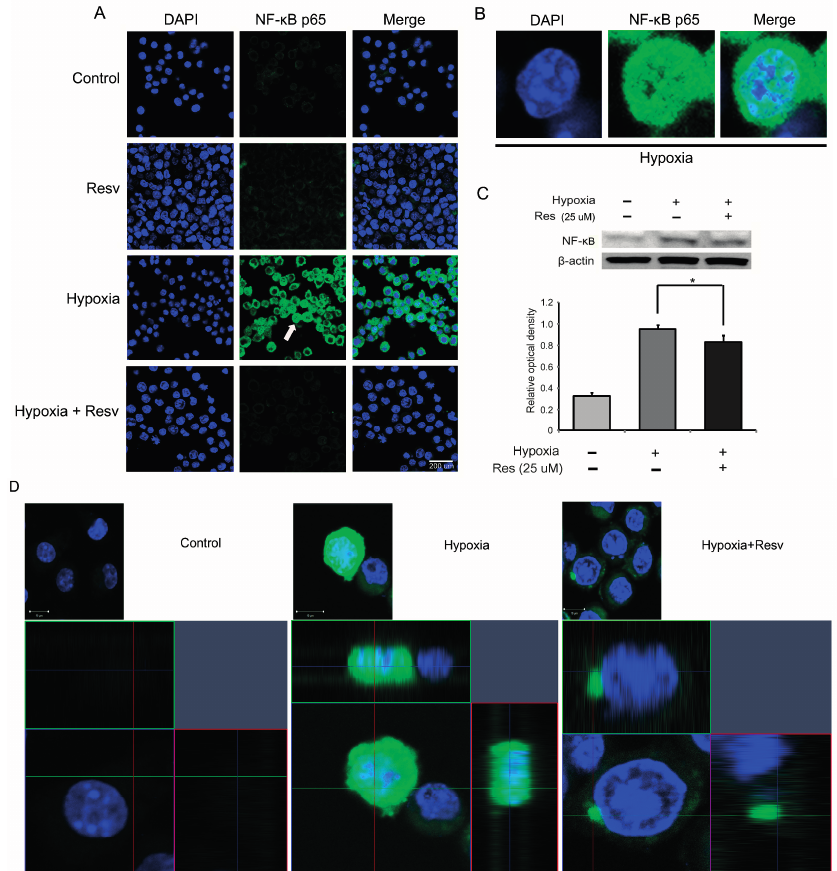
Figure 4. Measurement of NF- κ B activation in resveratrol pre-treated BV2 microglia under hypoxic conditions. ( A ) The activation of NF- κ B was evaluated with immunocytochemistry. This image showed that the translocation of NF- κ B p65 to the nucleus of BV2 microglia in the hypoxia group was increased compared with the control group. The resveratrol (25 μ M) pre-treatment group (Hypoxia + Resv group) showed suppression of NF- κ B p65 translocation to the nucleus compared with the hypoxia group. Resveratrol (25 μ M) decreased the activation of NF- κ B under hypoxic conditions; ( B ) The high magnification image at the white arrow site in the hypoxia group shows that NF- κ B p65 enters into the nucleus; ( C ) Western blotting data showed that the protein level of NF- κ B p65 was increased in the hypoxia group compared to the control group. The protein level of NF- κ B p65 was decreased in the hypoxia + resv group compared to the hypoxia group. β -actin was used as an internal, loading control (mean ± S.E.M., n = 3). * p < 0.05 (compared to the hypoxia group); and ( D ) The hypoxia group shows the translocation of NF- κ B p65 into the nucleus compared with the normal group owing to the hypoxia injury. Resveratrol inhibited the translocation of NF- κ B p65 into nucleus in spite of hypoxia injury. Control : normal control group, Hypoxia : hypoxia injury group for 4 h, Resv : resveratrol (25 μ M) treatment group under normal condition, Hypoxia + Resv : resveratrol (25 μ M) pre-treatment before 4 h hypoxia injury, Res ( 25 μ M ): 25 μ M resveratrol pre-treatment for 3 h. 4',6-diamidino-2-phenylindole (DAPI): blue, Nuclear factor-kappa B (NF- κ B): green, Scale bar: 200